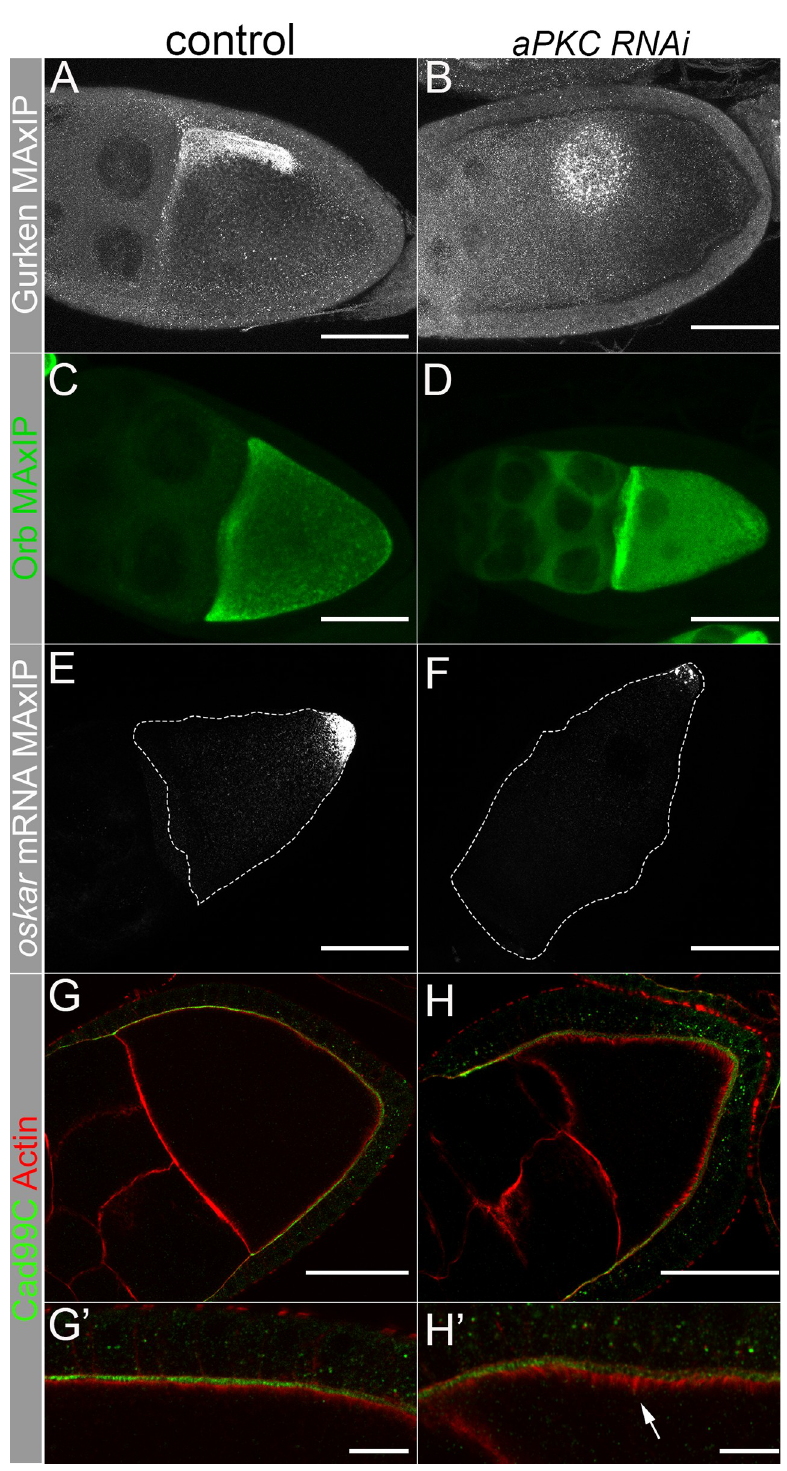
Fig 9. Germline expression of aPKC RNAi (35140) at midstages of oogenesis leads to germline polarity defects. Maximum intensity projections show that the patterns of Gurken protein(A-B), Orb protein(C-D) osk mRNA(E-F), and actin (G-G’,H-H’) are altered when aPKC RNAi (35140) is driven by maternal α -tubulin Gal4 ( 7063 ). In this background, the oocyte nucleus is not always positioned at the dorsal anterior corner and Gurken protein remains localized with the oocyte nucleus. Orb protein accumulates along the anterior margin of the oocyte and osk mRNA